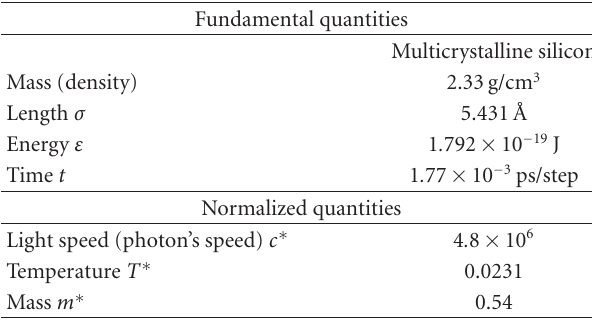
Table 1: Parameters of physical models, the bandgaps of the most important semiconductors for solar-cell